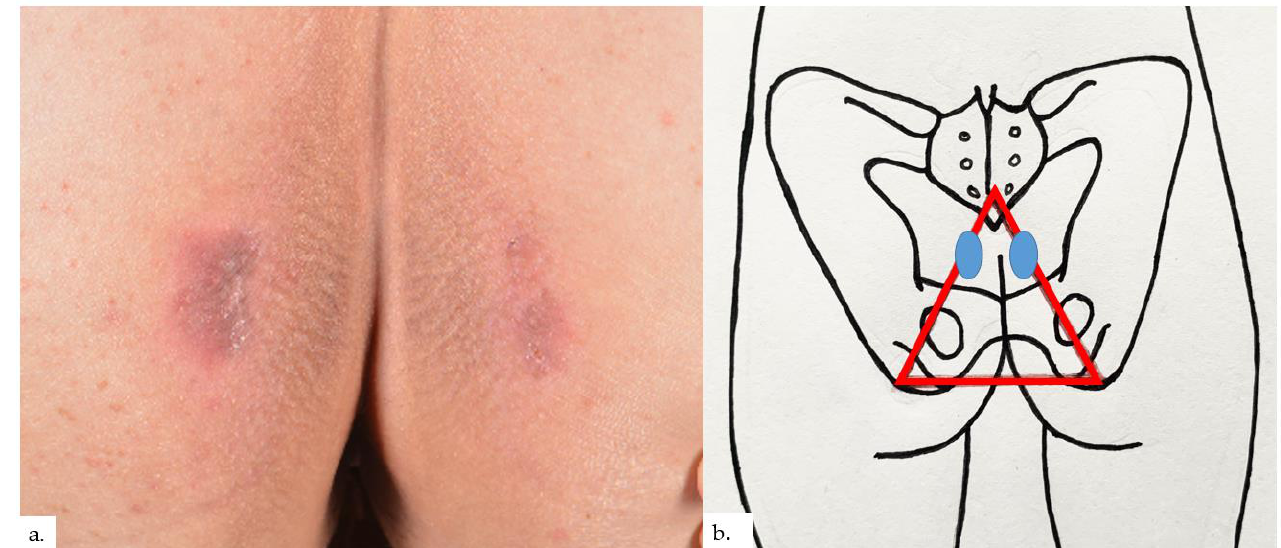
Figure 1. Patient 1. ( a ) Presence of symmetrical erythematous plaques over both buttocks, with some superficial scaling and surrounding lichenification showing characteristic horizontal hyperkeratotic ridges; ( b ) the plaques (blue ovals) were inferio-lateral to the coccygeal apex, at the apex of the sitter’s triangle (red triangle).